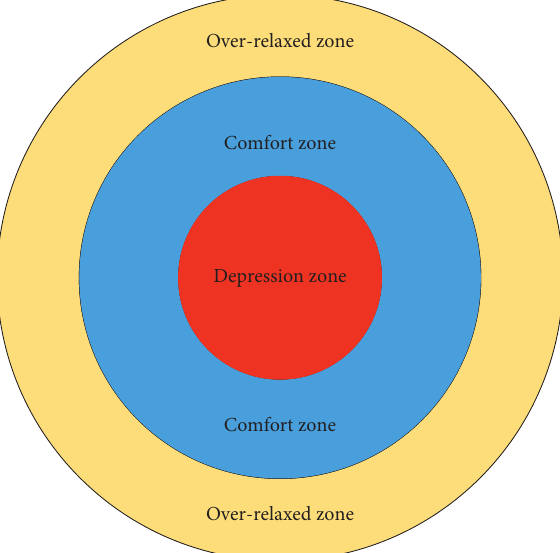
Figure 3: Three zones of drivers’ psychological status.